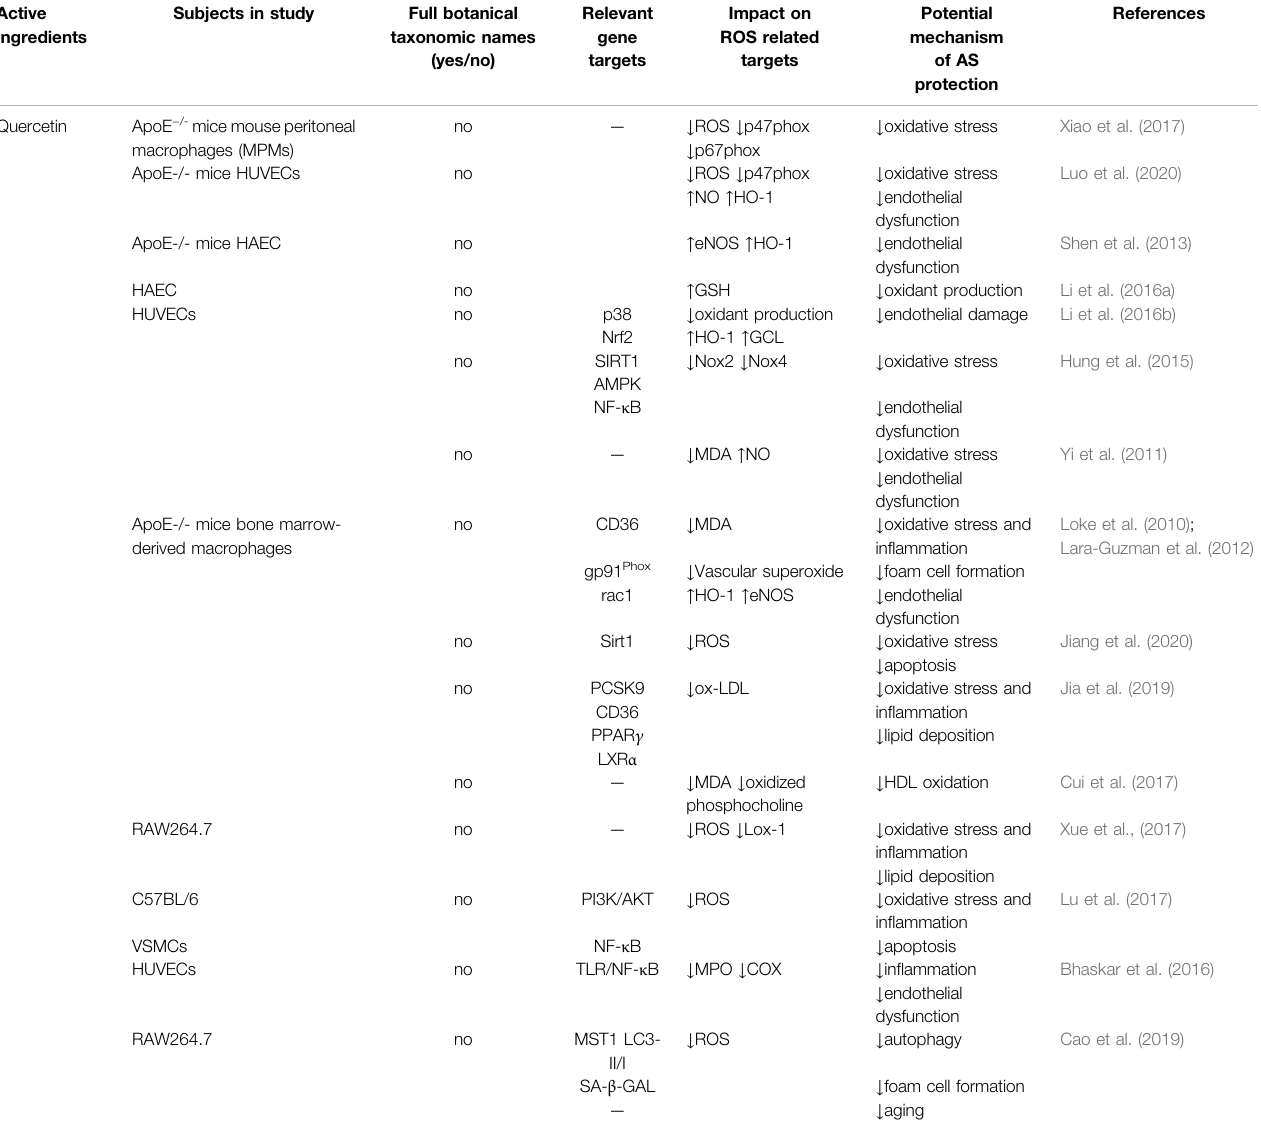
TABLE 6 | Quercetin for treatment of atherosclerosis by regulating oxidative stress. Active ingredients